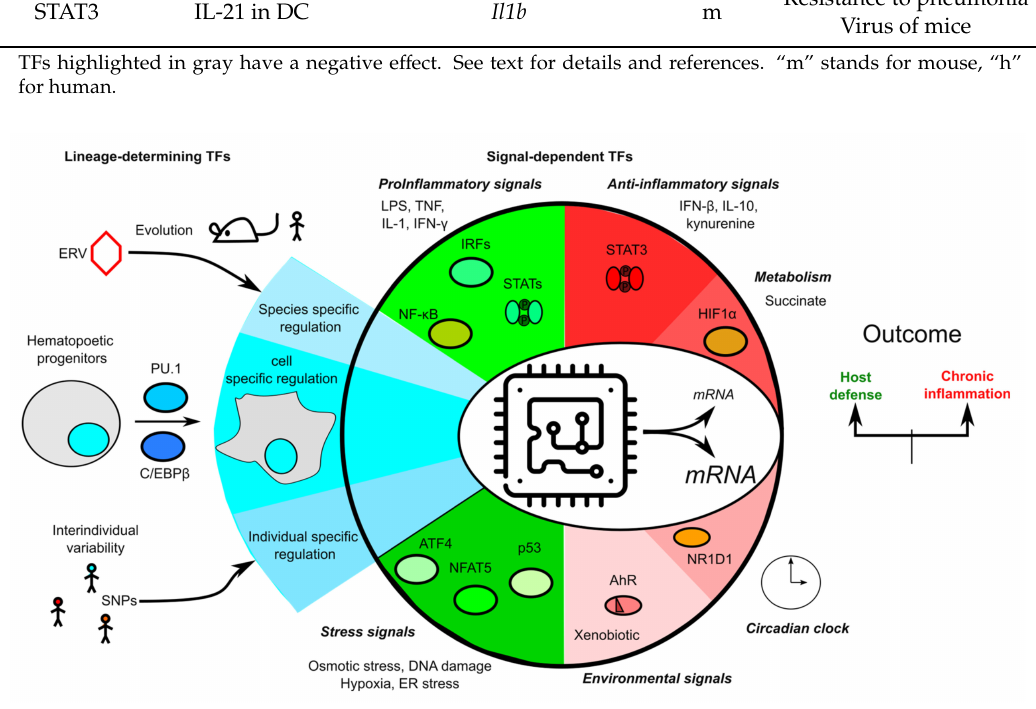
Figure 5. Overview of the transcriptional regulation of inflammasome genes.